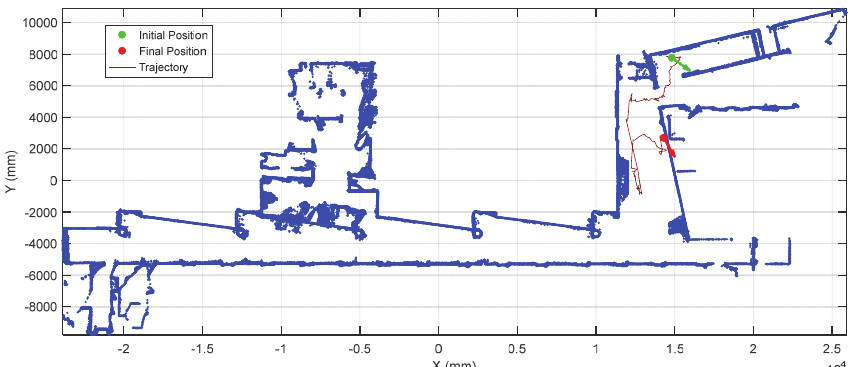
Figure 16. 2D projection of a scan gathered by the LIDAR placed at the starting position shown in Figure 15. The arrow depicts the location and orientation of the mobile robot, the green dots depict scan points classified as ground points.